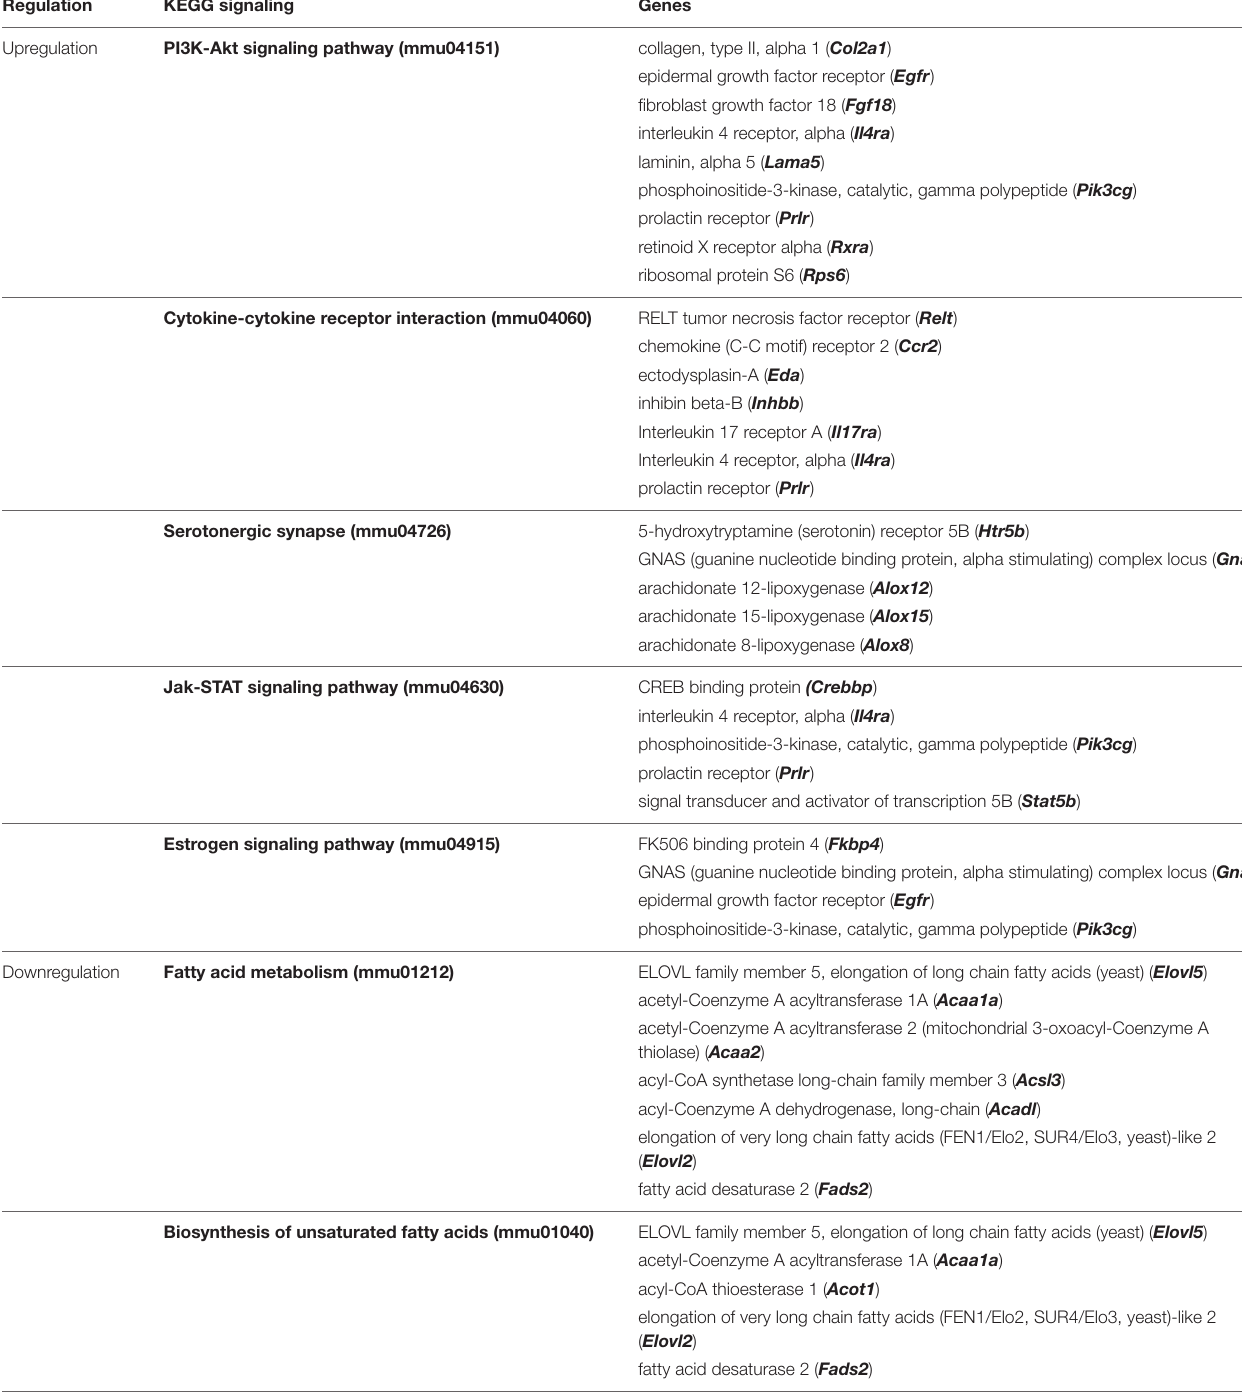
TABLE 4 | Top significantly enriched KEGG signaling pathways in Hippocampus of LPS-induced depression mice treated with luteolin (LPS + L) compared to untreated LPS-induced depression mice (LPS).